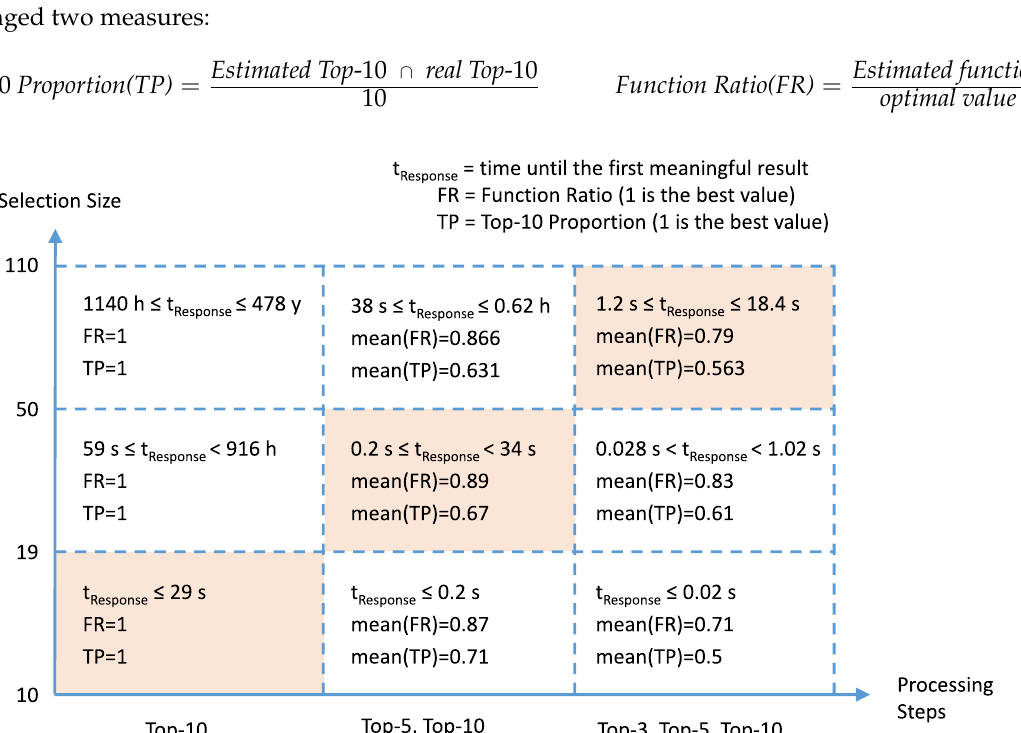
) on the whole selection, via (2) computing ( n ) 10 5 ) on the whole 10 ) , ( n ) , ( n ) splitting 3 5 10